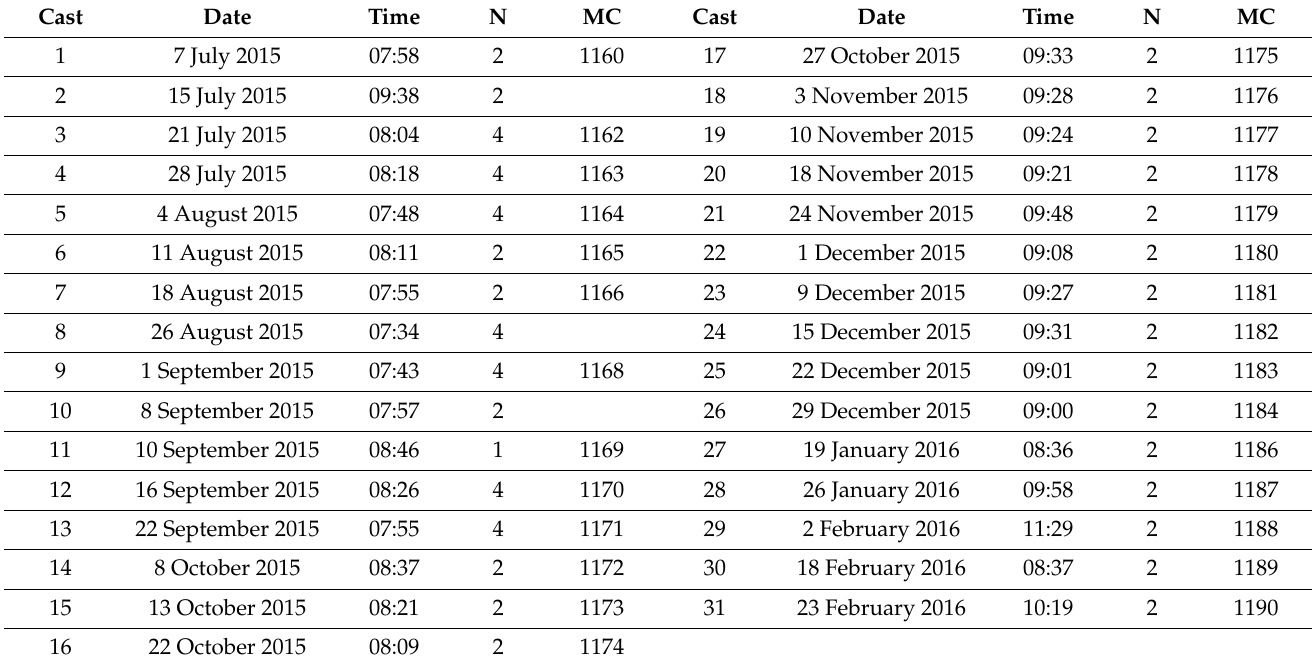
Table 1. Dates and time (local time = UTC + 1) of each VMP cast, with the number N of profiles created, and the LTER-MC reference number (cells are left blank when the VMP cast was not performed on the same day as the MC